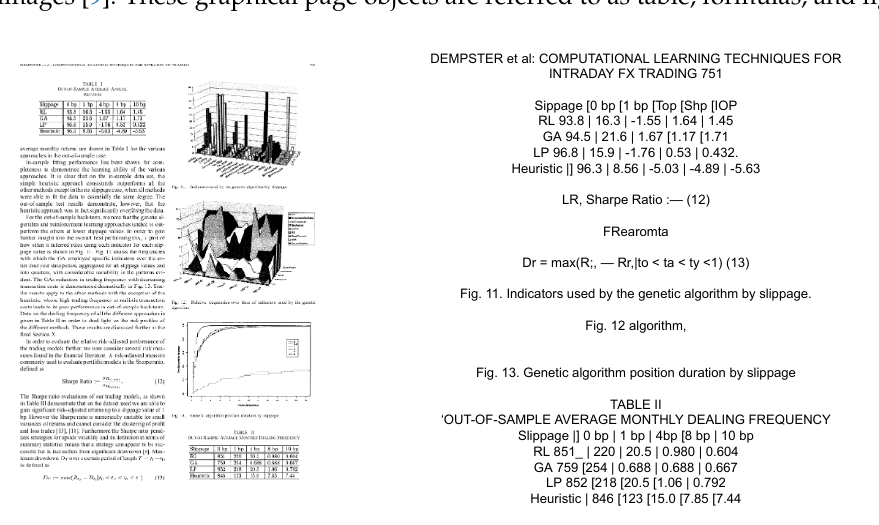
Figure 2. An illustration of information extraction through the conventional OCR method. On the left side of the figure, there is a document image containing multiple graphical page objects taken from the ICDAR-17 POD dataset [5], whereas the extracted information is present on the right side. We have applied an open-source Tesseract OCR [6] to extract the information. Since the OCR correctly recognized the textual content, we only demonstrate the extracted information from graphical page objects for brevity. The incorrectly extracted content depicts that graphical page object detection is an essential preliminary step before information